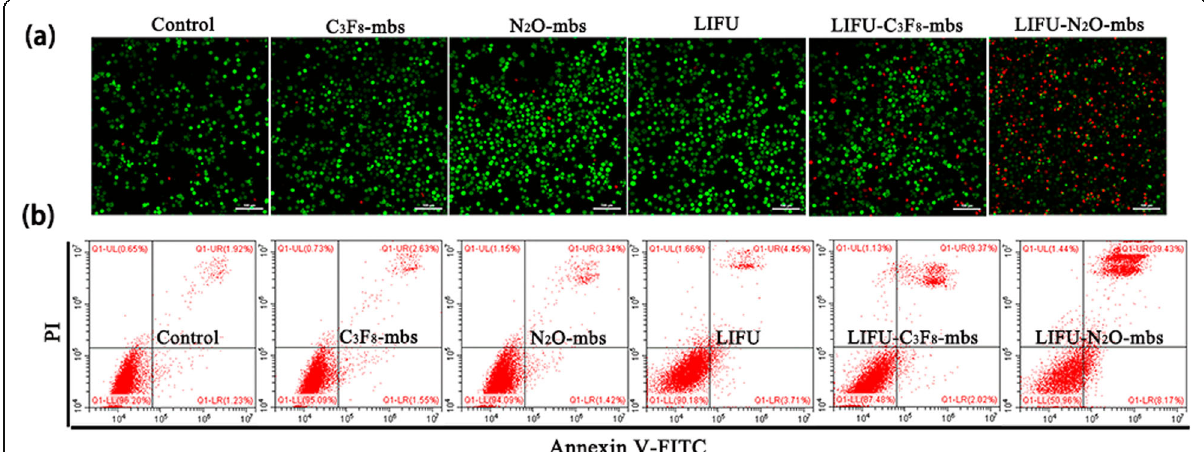
Fig. 4 a Flow cytometry analysis of tumor cell apoptosis and necrosis; b confocal images of CAM/PI co-stained MDA-MB-231 cells after various treatments. The scale bars are 100 μ